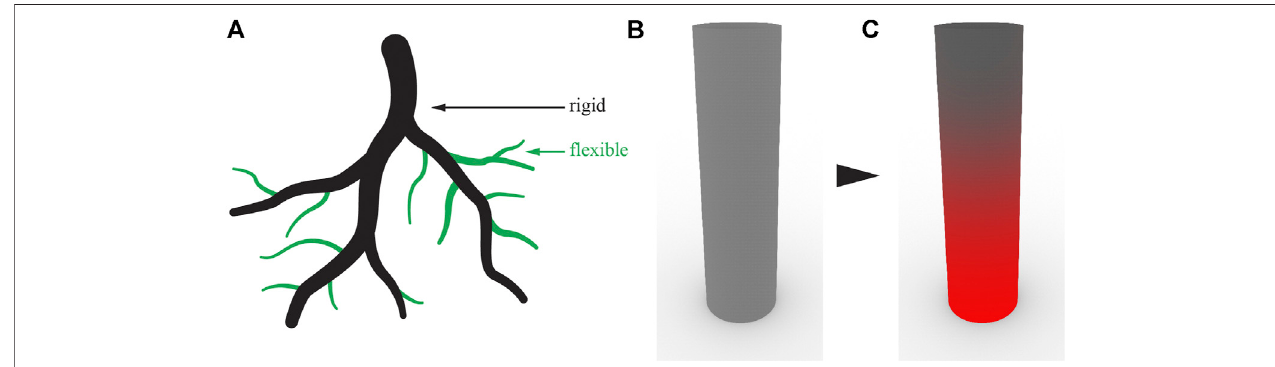
FIGURE 13 | Multifunctional composites — (A) — A root-like structure with the black elements comprising a rigid material and the green elements comprising a fl exible material. A standard construction pile made of one material is shown in (B) while an innovative composite pile is shown in (C) , composed of a material gradient from more rigid (red) at the base of the pile to more fl exible (grey) at the top of the